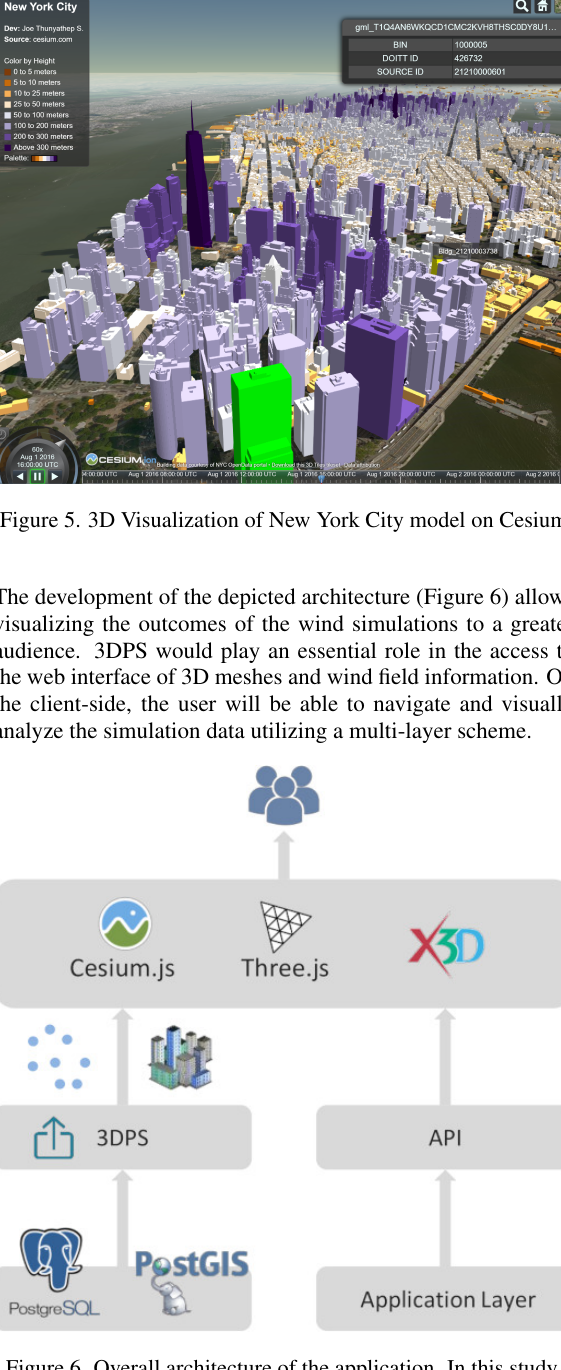
Figure 6. Overall architecture of the application. In this